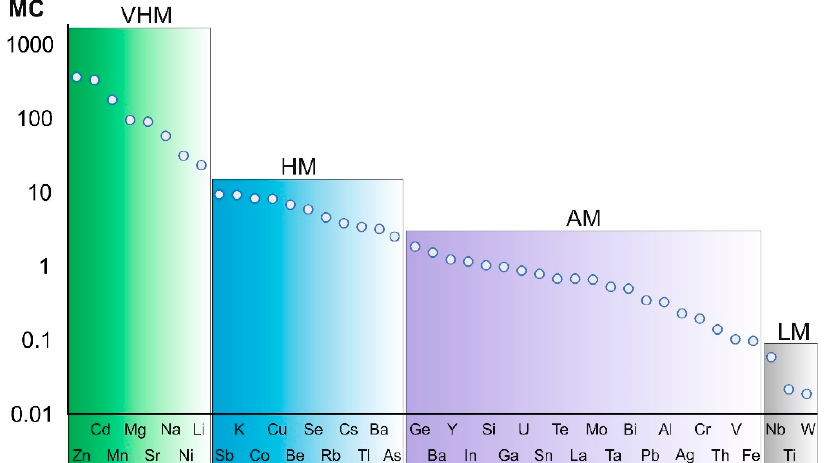
Figure 4. Mobility of chemical elements during the transition from Shahtama tailings to solution. MC is the mobility coefficient. VHM, HM, AM, LM—four groups of very high, ultra-high, medium, and low mobility, respectively.